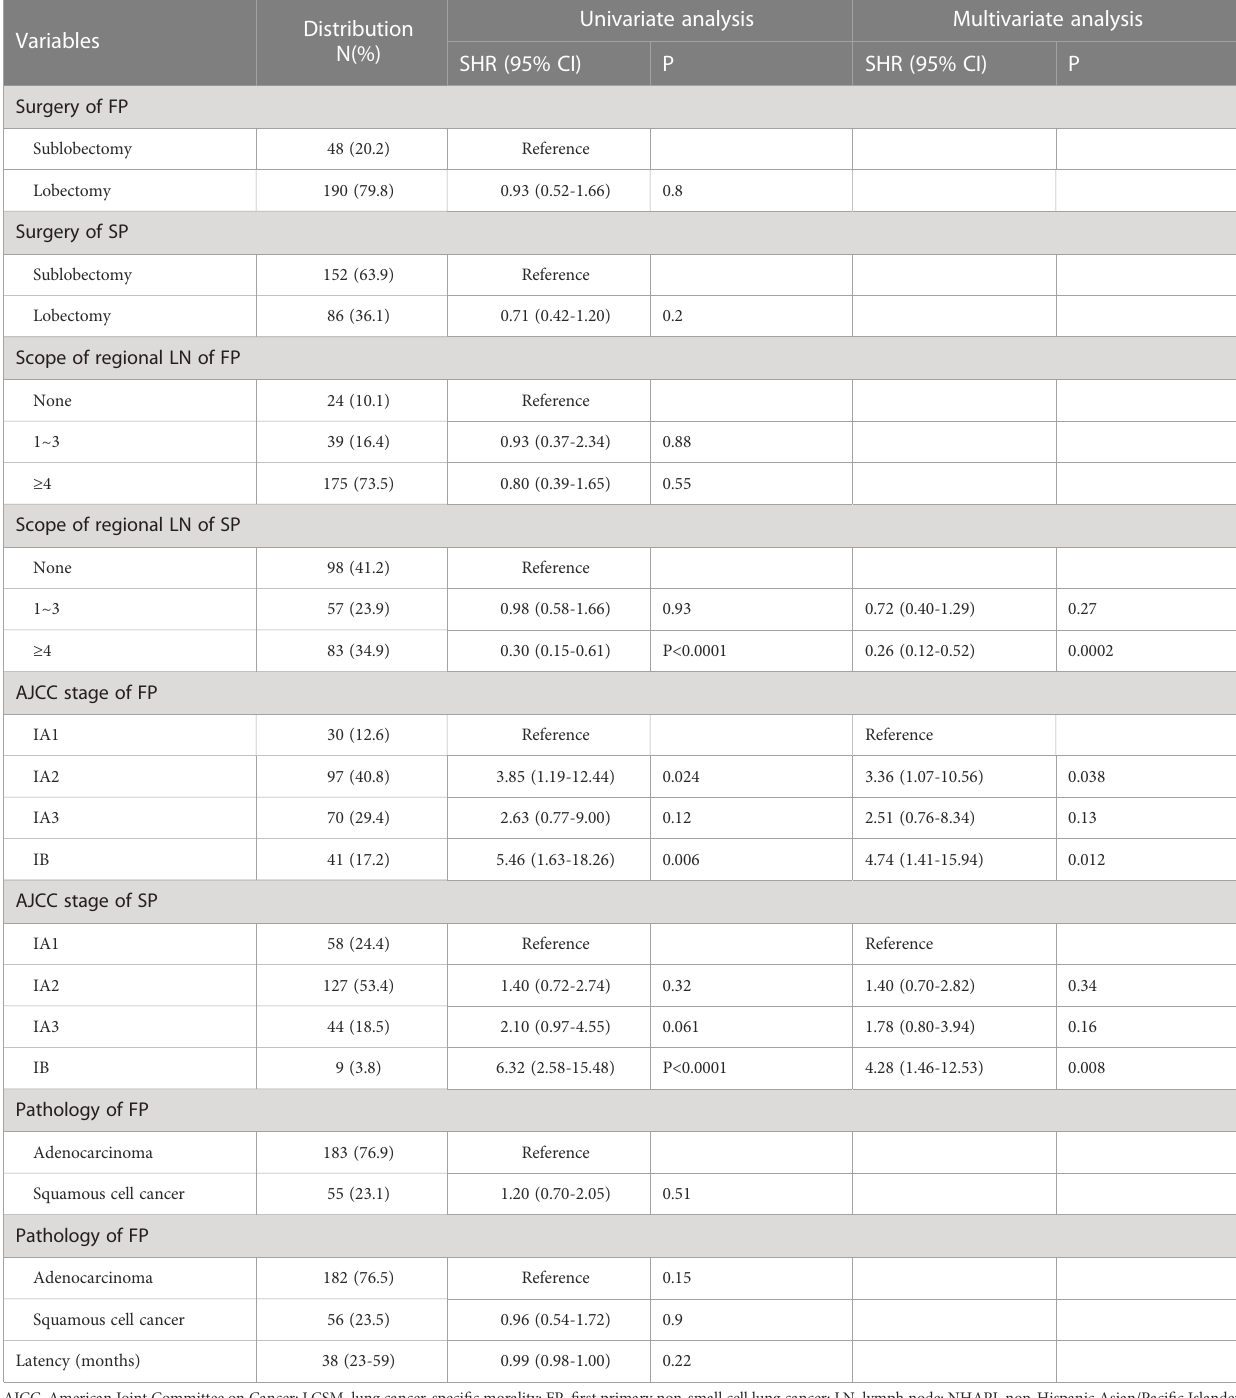
of sublobectomy (Table 2), and the SP patients who underwent lobectomy had a higher proportion of ≥ 4 regional LN dissections (Table 3). A total of 72 (29.0%) patients died of lung cancer, and 37 (14.9%) died of other causes (Figure 2). In addition, the SP patients who underwent ≥ 4 regional LN dissections had the highest proportion of patients alive, while the SP patients without regional LN dissections had the lowest proportion (Figure 2).